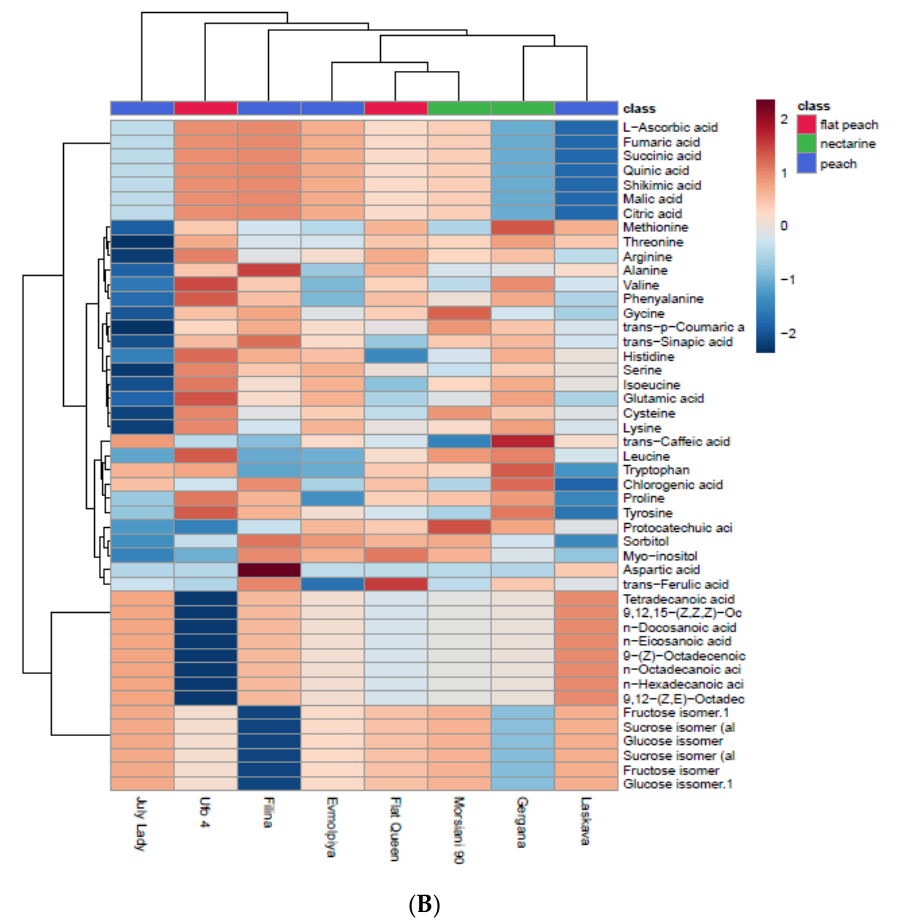
Figure 3. Clustering results for eight peach cultivars, shown as a heatmap: ( A )—WF, ( B )—FP. The values were normalized by log 10 transformation.